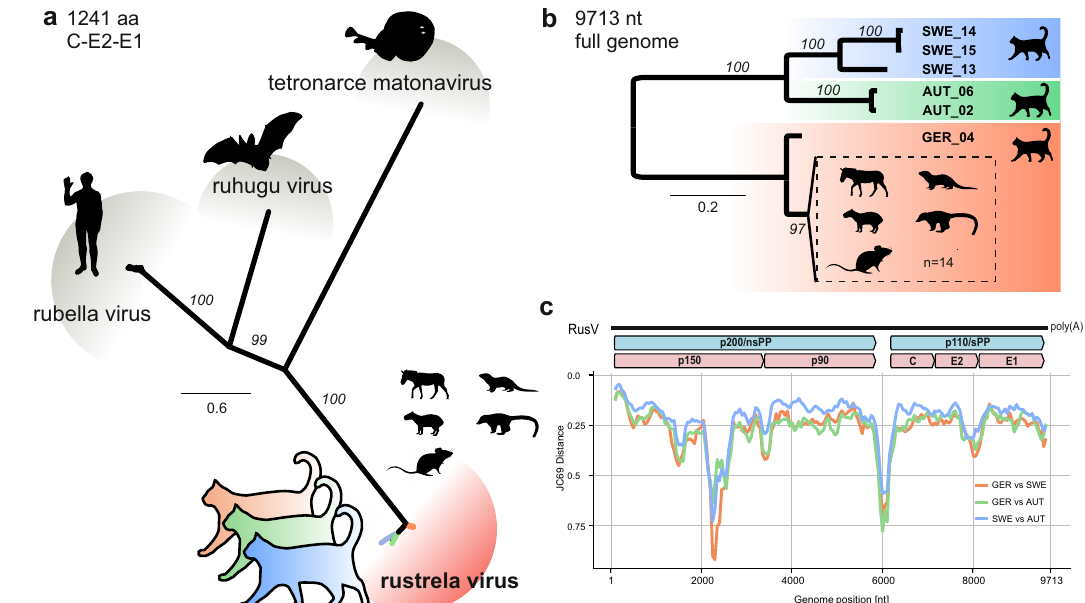
Fig. 1 | Sequence comparison of complete rustrela virus (RusV) genome sequences from cats from Sweden, Austria, and Germany. a The amino acid sequences of the structural polyprotein (p110/sPP) of all known matonaviruses were aligned and a maximum-likelihood (ML) phylogenetic tree was calculated (IQ-TREE2 version 2.2.0; FLU+F+I+G4; 100,000 ultrafast bootstraps). Boot- strap support values are shown in italics. b ML tree of complete or nearly com- plete RusVgenome sequences fromcatswith ‘ staggering disease ’ andallpublicly available RusV sequences (IQ-TREE2 version 2.2.0; TIM3+F+I; 100,000 ultrafast bootstraps). Sequences from Sweden, Austria, and Germany are highlighted in blue, green, and orange, respectively. Sequences from a previously identi fi ed